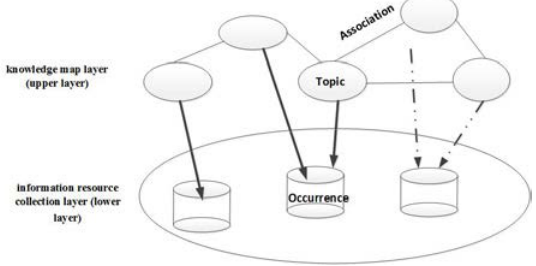
Figure 1. Two-layer structure schematic diagram of Topic